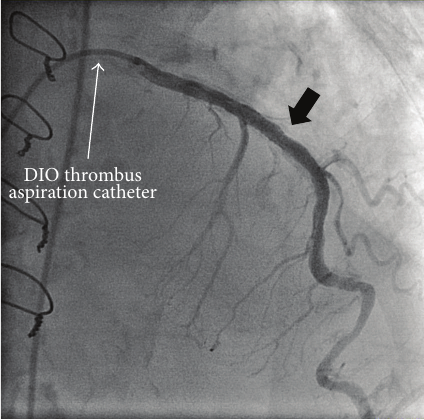
Figure 3: Coronary angiography after percutaneous coronary inter- vention. The residual stenosis was <